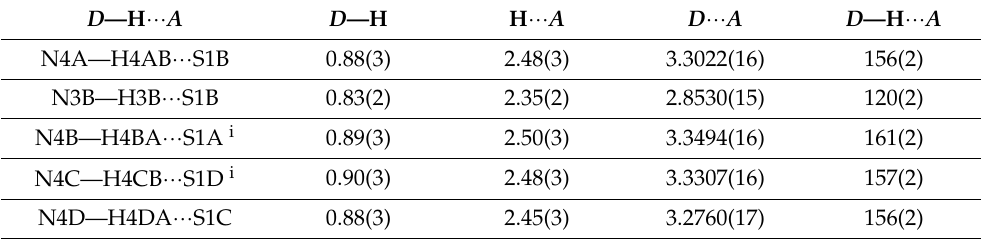
Table 8. Hydrogen-bond geometry (Å, ◦ ) for 6 .